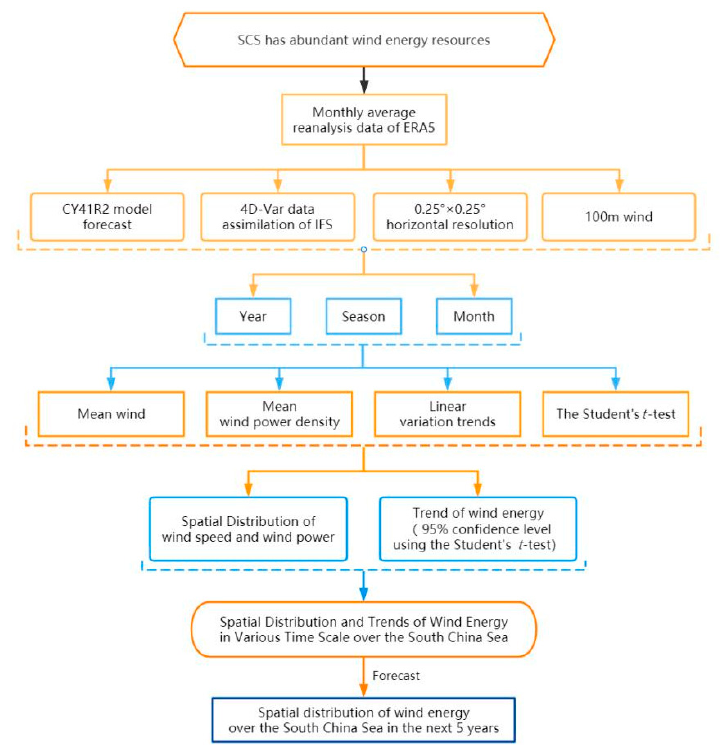
Figure 1. The flowchart utilized for this